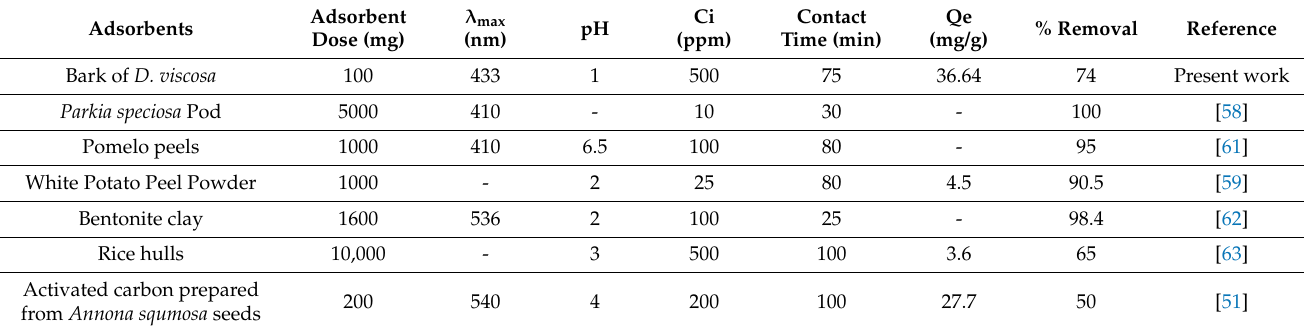
Table 3. Comparison of adsorption capacity of the bark powder of Hopbush ( D. viscosa ) with previously studied adsorbents for the removal of MR dye from aqueous